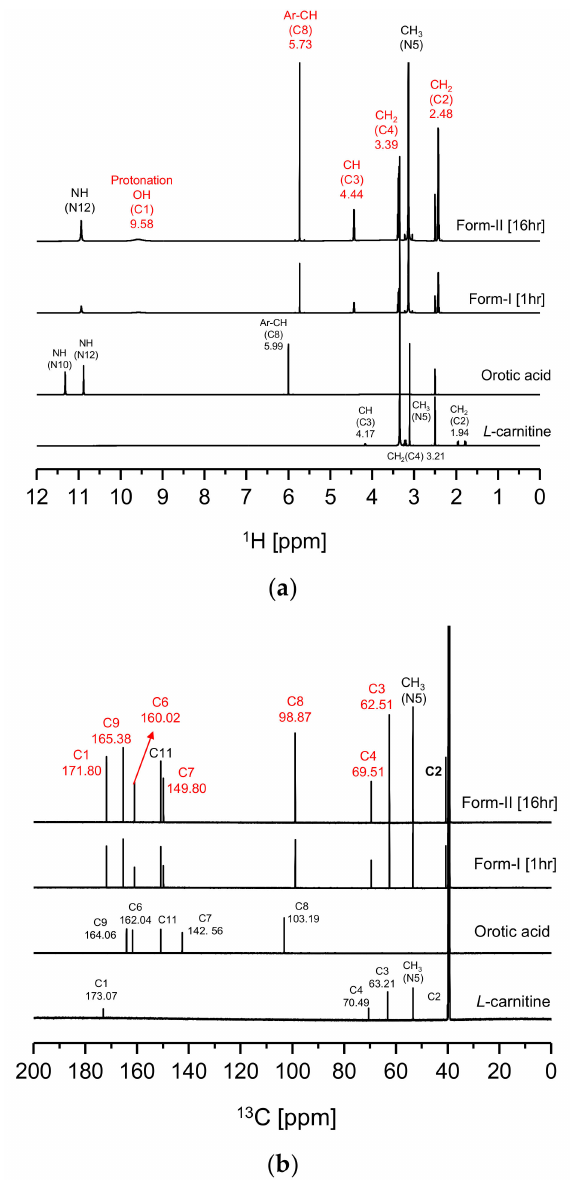
Figure 4. Solution-state 1D-NMR data of CO: ( a ) 1 H-NMR, ( b ) 13 C-NMR (numbers on spectral